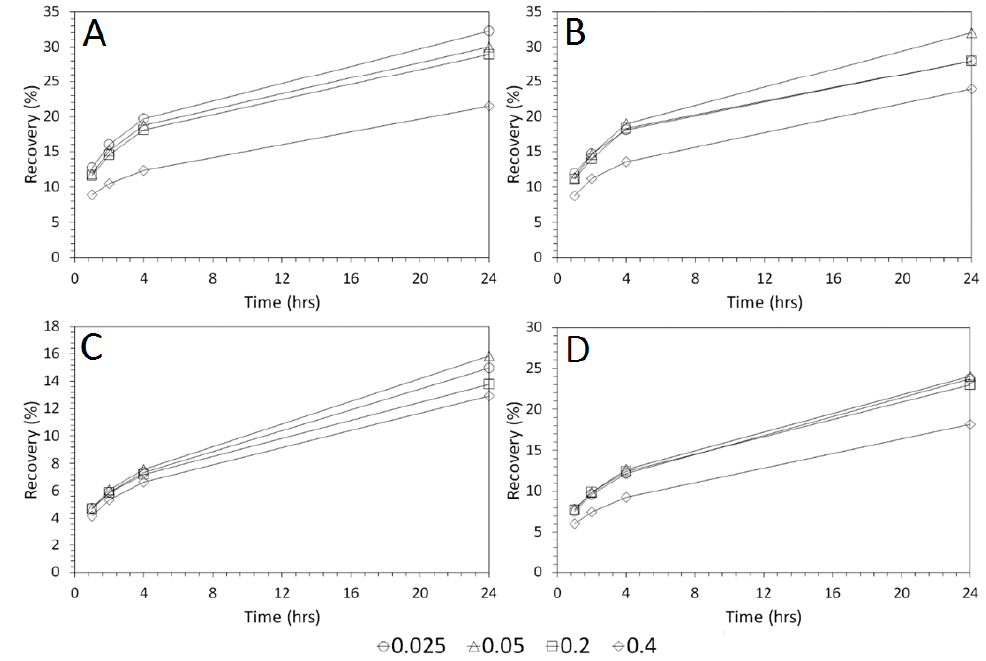
Figure 8. Cu recovery as a function of time for solid – liquid ratios of 0.025, 0.05, 0.2, and 0.4 using: H 2 SO 4 ( A ), HCl ( B ), C 6 H 8 O 7 ( C ) and CH 3 SO 3 H ( D ). The acid concentrations were 1 M and lixiviant volumes were 200 mL.